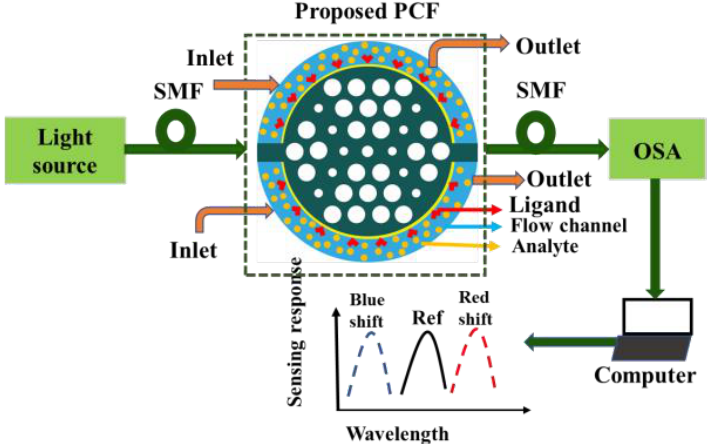
Figure 2. The typical sensing mechanism of the proposed sensor.